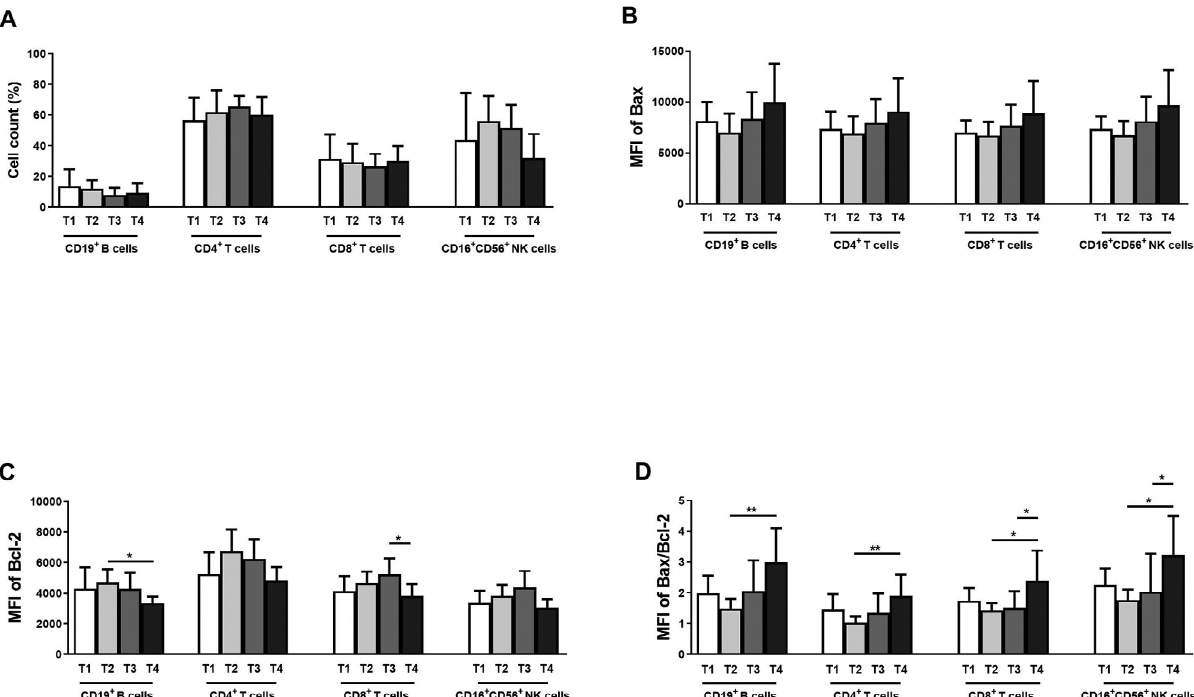
Figure 5- Comparison based on tumor size among T1, T2, T3, and T4 samples. Percentage of cells in the four lymphocyte subtypes (A). MFI of Bax, Bcl-2, and Bax/Bcl-2 of the four lymphocyte cell types (B-D). *: p <0.05, **: p <0.01